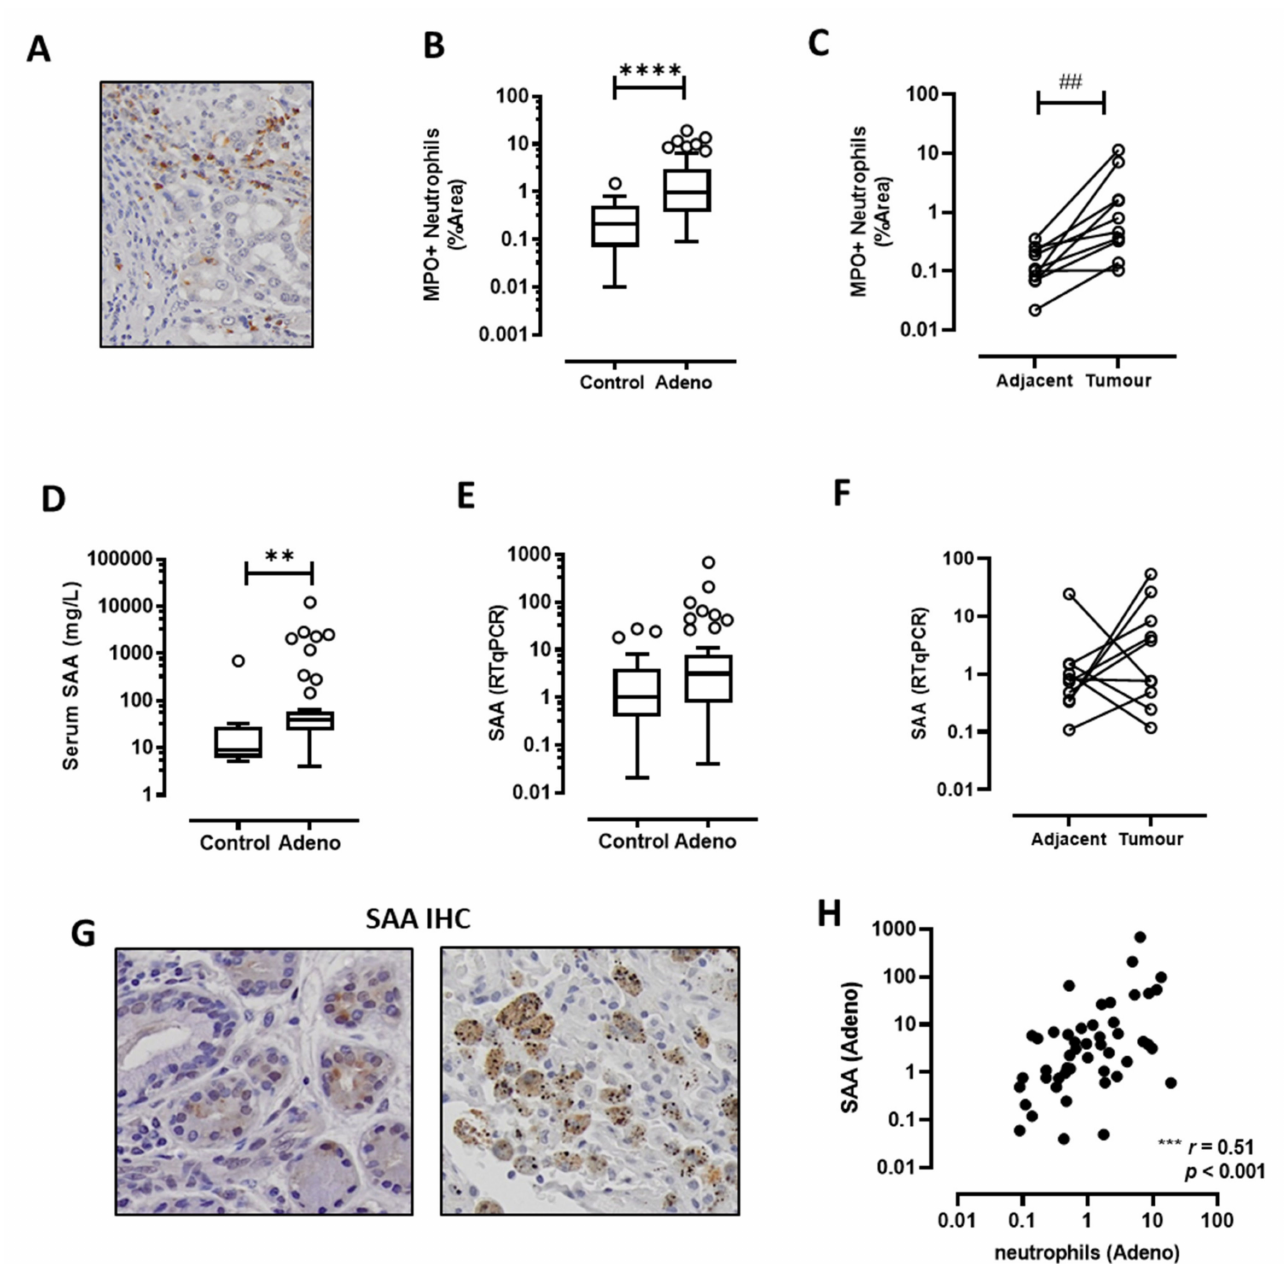
Figure 1. SAA levels positively correlate with tumour-associated neutrophil infiltration. ( A ) Representative images of MPO-positive neutrophils in a lung adenocarcinoma tumour section (original magnification × 200). ( B ) Neutrophils are significantly elevated in tumours compared to control tissue biopsies, which was confirmed by ( C ) paired analysis of tumour and adjacent control lung tissue. ( D ) Circulating SAA levels were elevated in lung adenocarcinoma patients as determined by ELISA. ( E ) SAA transcript levels were not increased in tumours as measured by RTqPCR and confirmed by ( F ) sub-analysis of the paired from the tumour and adjacent control tissue samples. ( G ) Tissue sections were stained for SAA, which identified positive staining within seromucinous glands and tumour-associated macrophages (original magnification × 200). ( H ) Spearman correlation was used to assess associations between SAA transcript levels and tumour infiltrating neutrophil density ( r = 0.51, *** p < 0.001). **** p < 0.0001, ** p < 0.01, ## p <